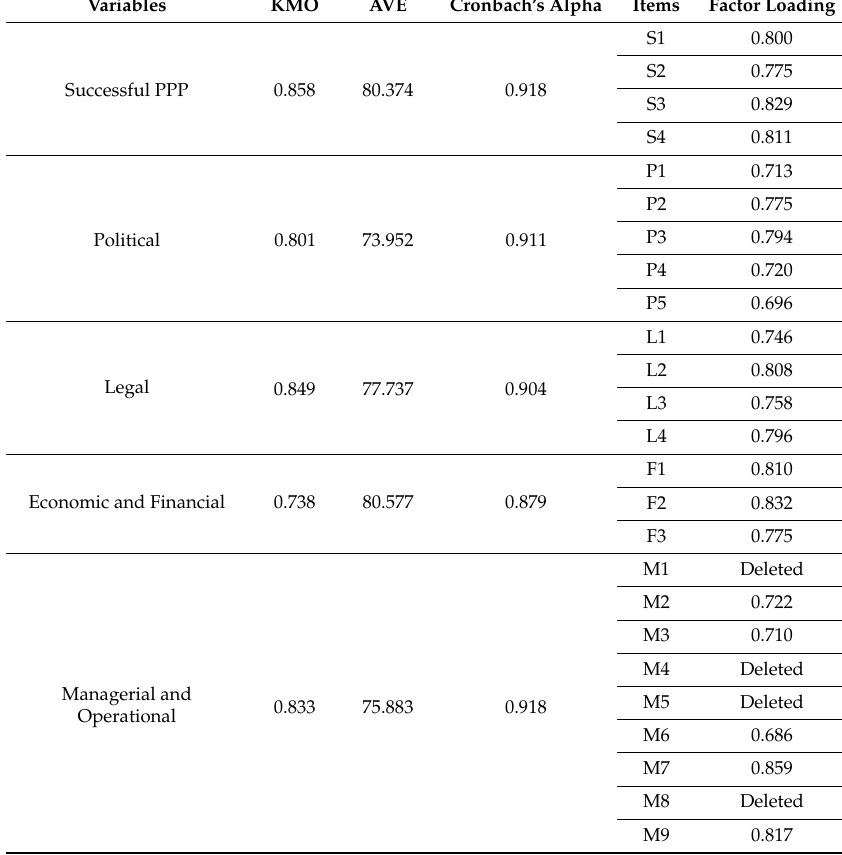
Table 9. Validity and reliability tests for the research variables of pilot study.